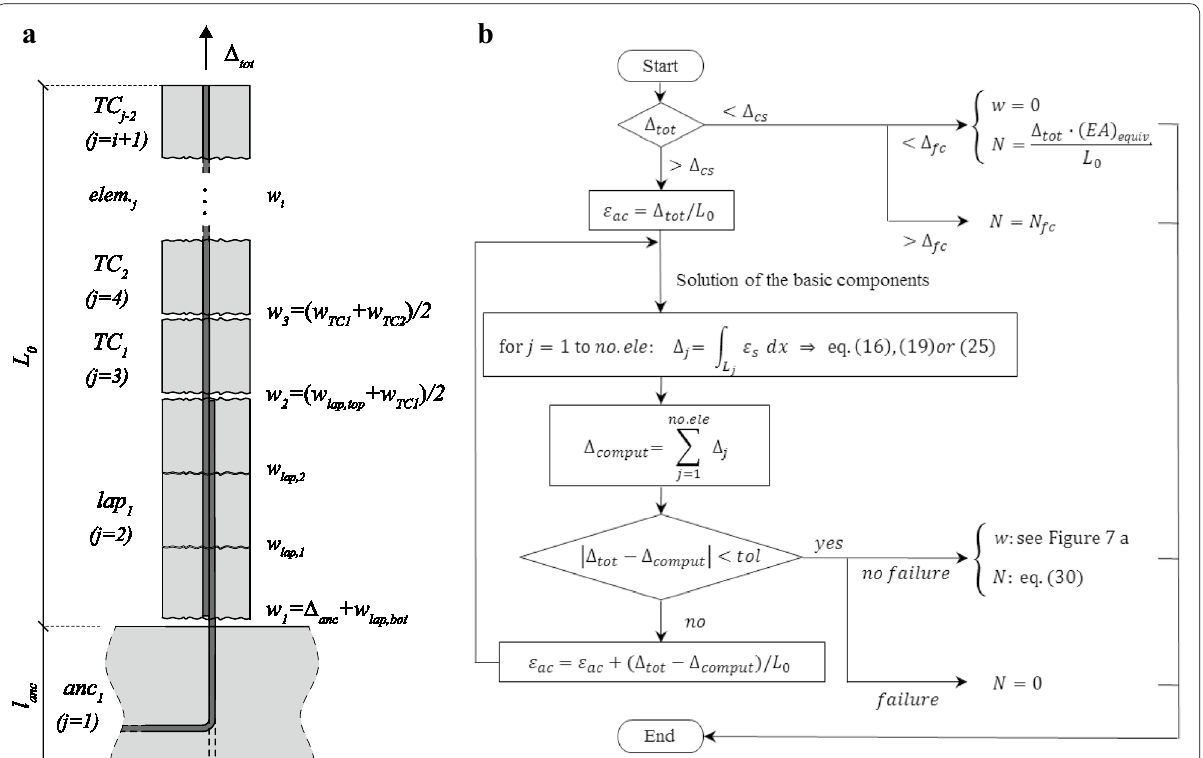
Fig. 7 RC boundary element model: a Assembly of the components for a RC member featuring lap splice, anchorage, and multiple basic tension chord ( TC i ) elements. b Flowchart of the iterative